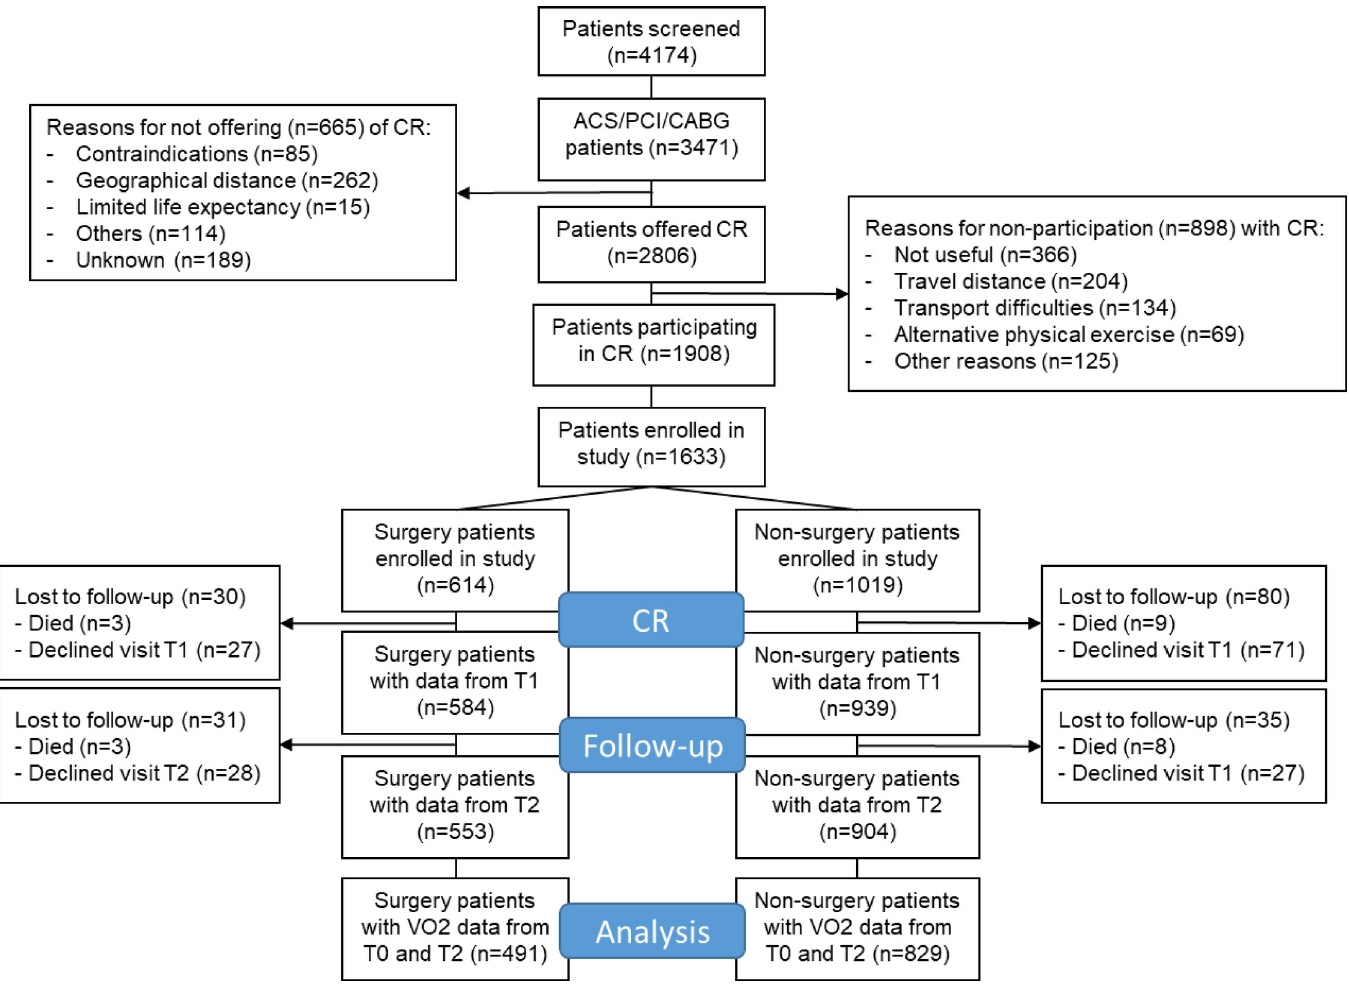
Fig 1. Study flow. Analysis refers to primary outcome change in peak VO 2 from baseline to 1-year follow-up.